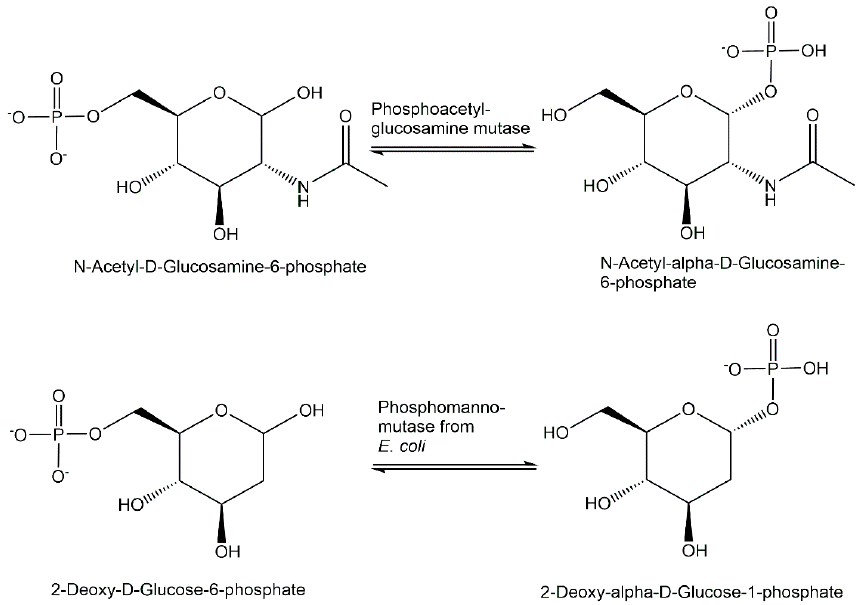
Figure 16. Synthetic applications of phosphomutases in phosphorylation reactions.